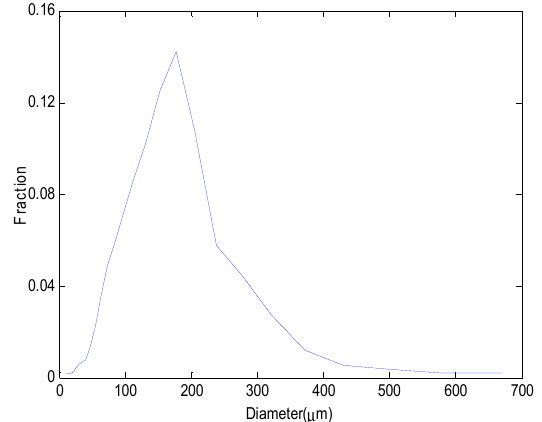
Figure 10. Mass fraction of droplet size distribution from 10 μ m to 670 μ m.